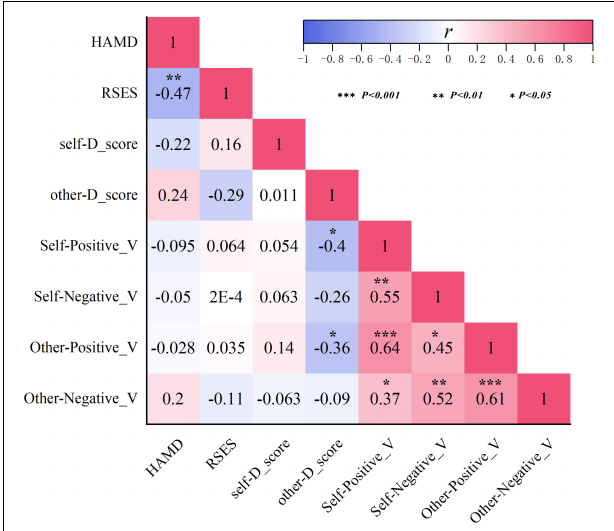
FIGURE 5 | Correlations among indicators of HAMD scores, RSES scores, D-scores, and go-P3 amplitudes in the MDD group. HAMD, Hamilton Depression Rating Scale; RSES, Rosenberg Self-Esteem